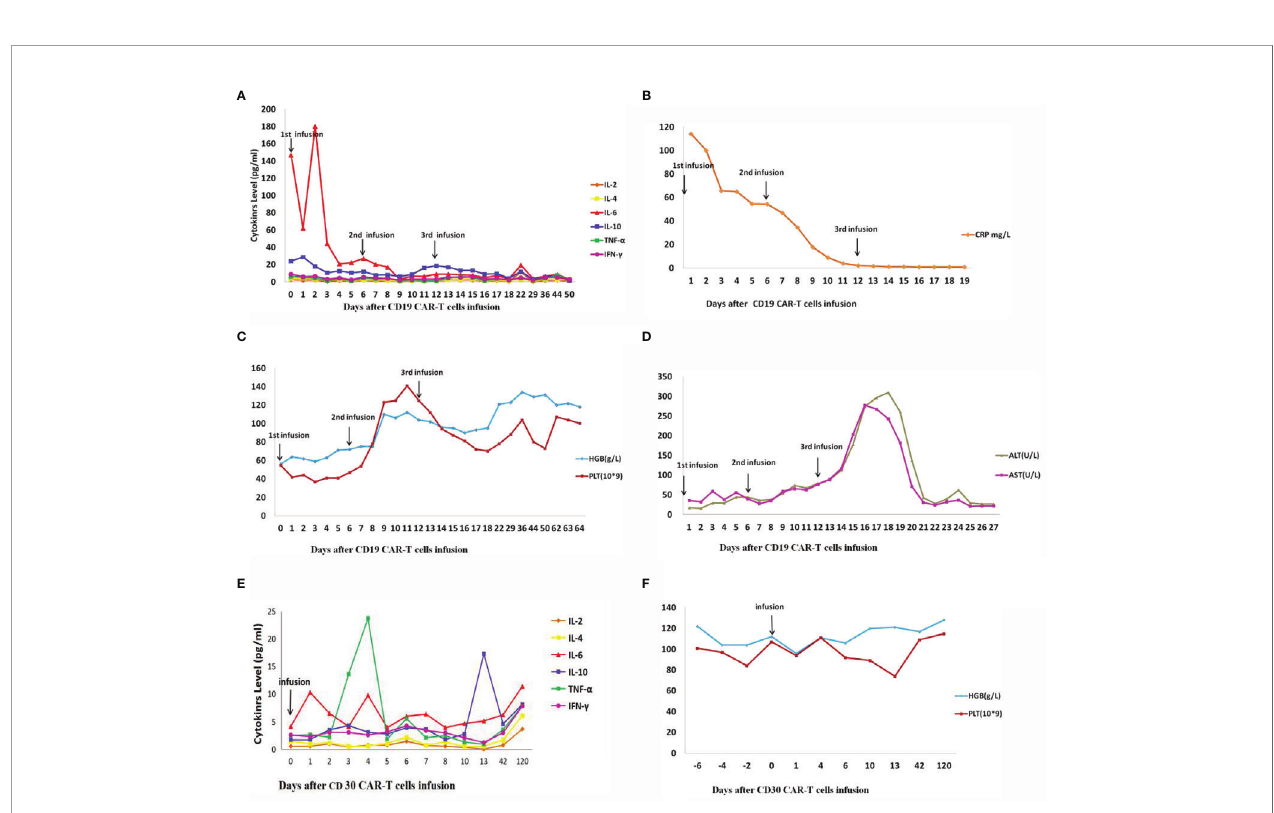
FIGURE 5 | IL, interleukin; TNF, tumor necrosis factor; IFN, interferon; CRP, C-reactive protein; HGB, hemoglobin; PLT, platelet; ALT, alanine transaminase; AST, Aspartate transaminase. (A – D) Changes in cytokines and other factors after three times(1st, 2nd, and 3rd) CD19 CAR T-cell infusion. (E, F) Changes in cytokines and other factors after CD30 CAR T-cell infusion. (A) Cytokines change after CD19 CAR T-cell infusion. (B) CRP changes after CD19 CAR T-cell infusion. (C) HGB and PLT change after CD19 CAR T-cell infusion. (D) ALT and AST change after CD19 CAR T-cell infusion. (E) Cytokines change after CD30 CAR T-cell infusion. (F) HGB and PLT change after CD30 CAR T-cell